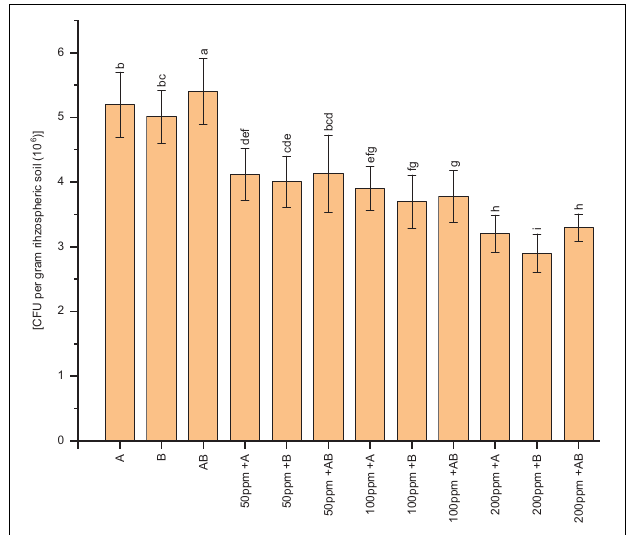
FIGURE 1 | Bacterial colonization [CFU per gram rhizospheric soil ( × 10 6 )] in the rhizosphere of wheat under control and heavy metal (Cd, Ni, Pb) stress conditions. All the values are the mean of three replicates. Bars represent the standard error of means. Different letters above the bars indicate statistically significant difference between treatments at P ≤ 0.05. A, Citrobacter werkmanii strain WWN1; B, Enterobacter cloacae strain JWM6; A + B, Citrobacter + Enterobacter consortium; 50 ppm, 50 ppm of Cd, Ni, and Pb; 100 ppm, 100 ppm of Cd, Ni, and Pb; 200 ppm, 200 ppm of Cd, Ni, and